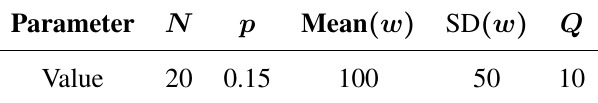
Table 1. Baseline scenario parameter settings.